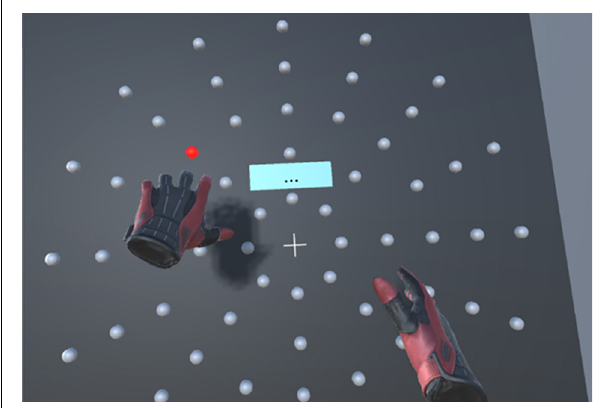
FIGURE 1 | View of the display in virtual reality (VR). The red light represents the active target to be hit. Gloves represents the controllers the user holds in his